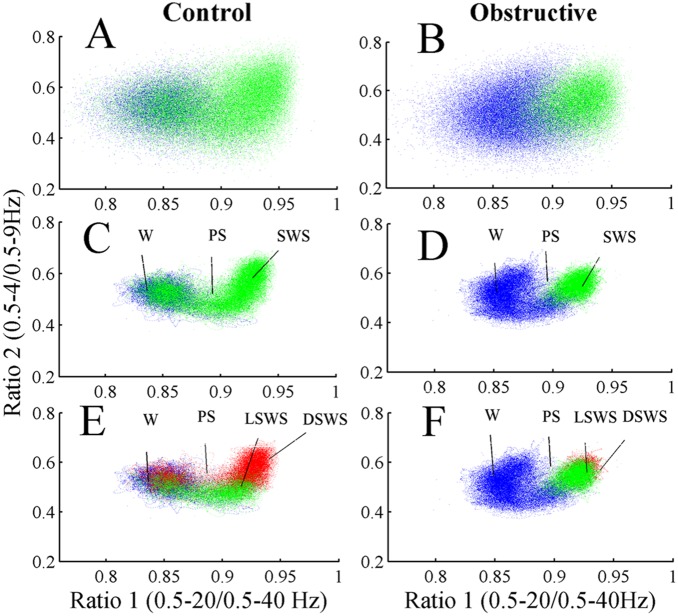
Spectral ratios of EEG activity define a 2-dimensional state space with distinct clusters.(A) control and (B) UAO; spectral ratios of EEG activity define a 2D state space with distinct clusters. Each plot shows 24 hours of EEG activity, and each point represents 1 second of EEG activity. (C) and (D) show 2D state space after application of a Hanning window (20 seconds) of one control and one UAO animal, respectively. Panels A–D: Blue–Wake; Green–slow wave sleep (SWS); Black–paradoxical sleep (PS). Panels E and F: light SWS (LSWS)–green; deep SWS (DSWS)–red.